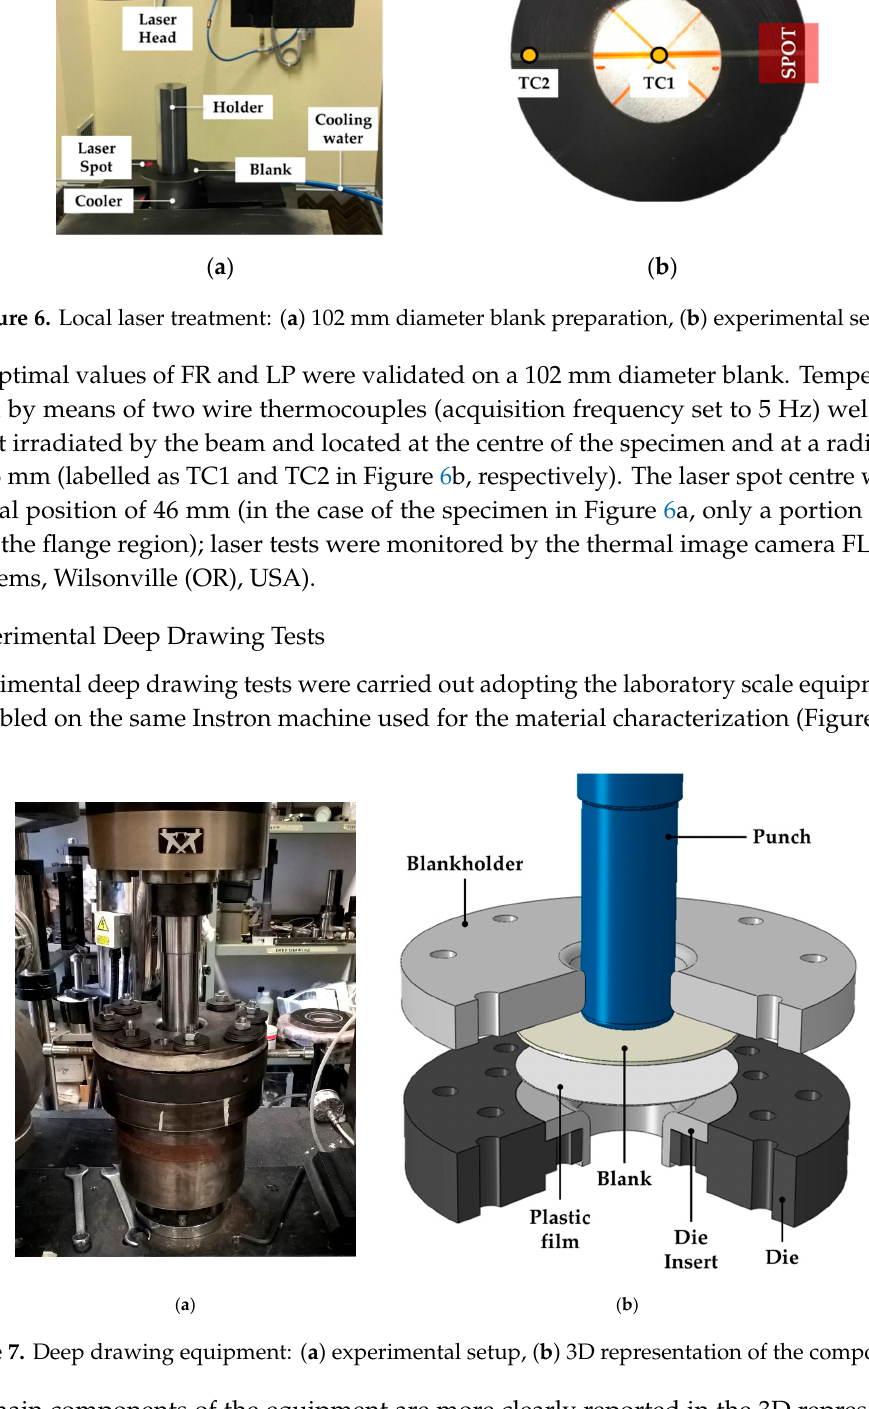
Figure 7. Deep drawing equipment: ( a ) experimental setup, ( b ) 3D representation of the components.